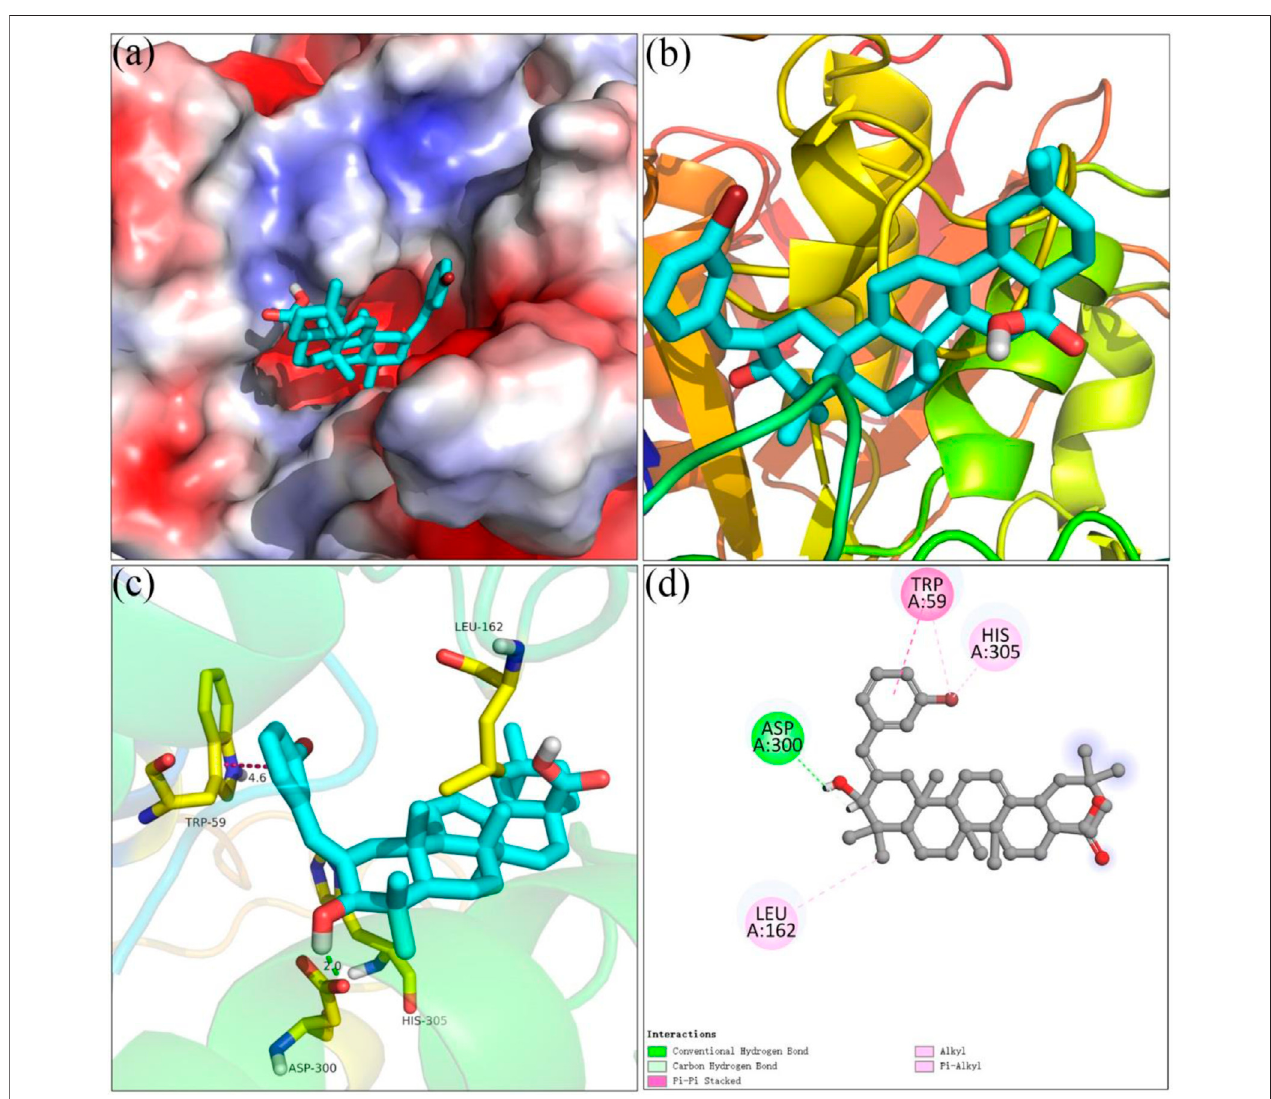
FIGURE4| Moleculardockingofanalog 4o and α -amylase. (A)4o intheelectrostaticsactivepocket; (B)4o intheactivepocket; (C) 3Dviewof 4o and α -amylase; (D) 2D view of 4o and α -amylase.